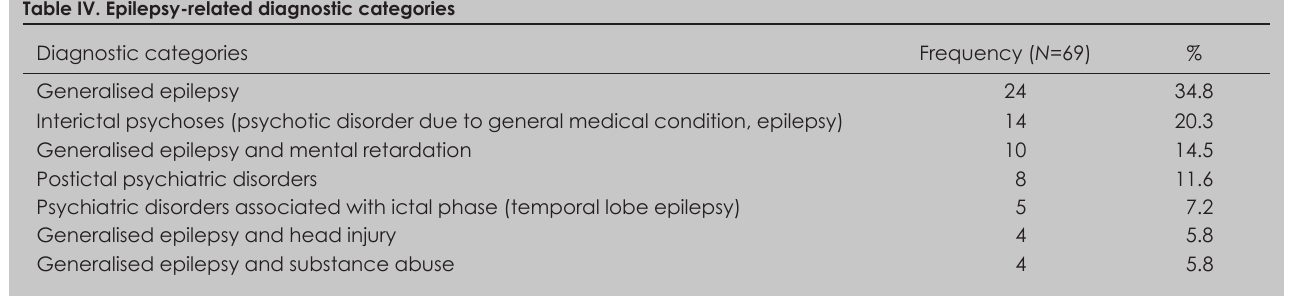
Table IV. Epilepsy-related diagnostic categories Diagnostic